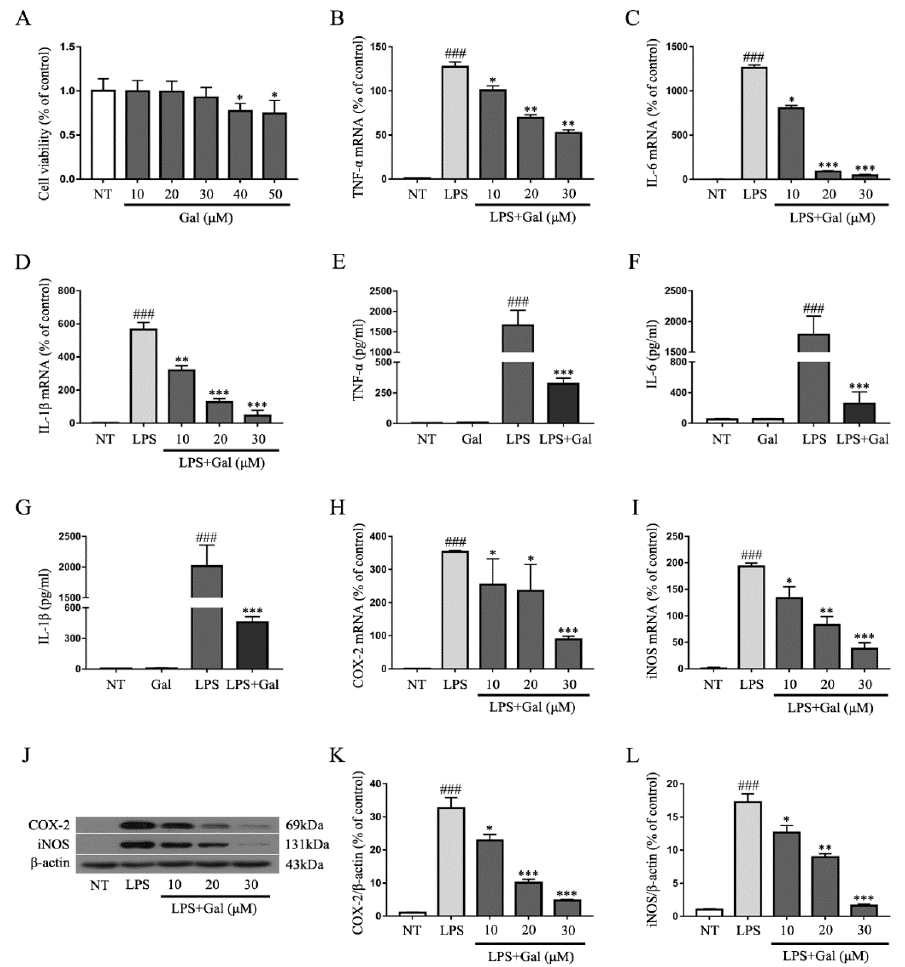
Figure 4. Galangin suppresses the LPS-induced inflammatory response in BV-2 cells. ( A ) The effects of galangin on BV-2 cell viability ( n = 5); ( B – D , H , I ) The BV-2 cells were stimulated with LPS for 4 h after pretreating with galangin for 1 h, and then cells were collected with Trizol. Gene expression of TNF- α , IL-6 , IL-1 β , COX-2 , and iNOS was detected by qRT-PCR ( n = 3). The BV-2 cells were stimulated with LPS for 12 h after pretreating with galangin for 1 h, and then, the supernatant was collected. The